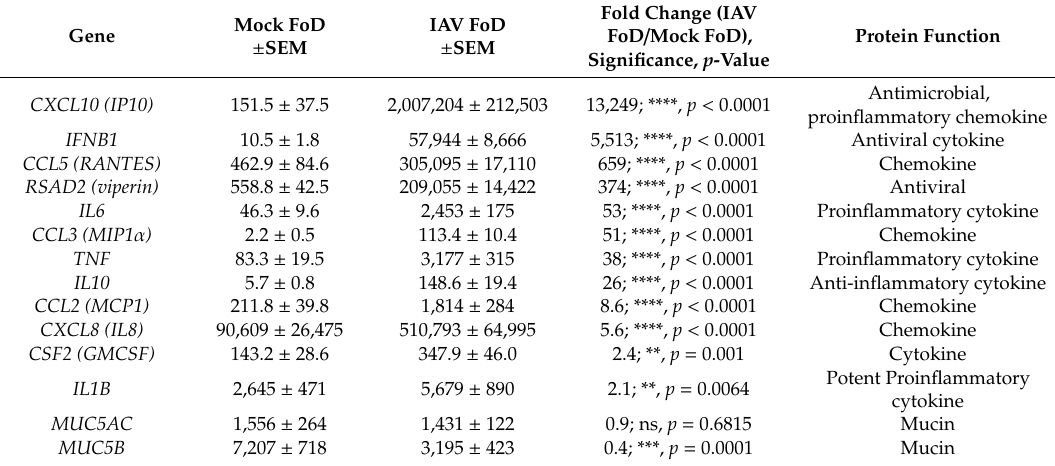
Table 1. Fold change (FoD) in gene expression 30 h postinfection with IAV H1N1pdm09- versus mock-inoculated wdNHBE